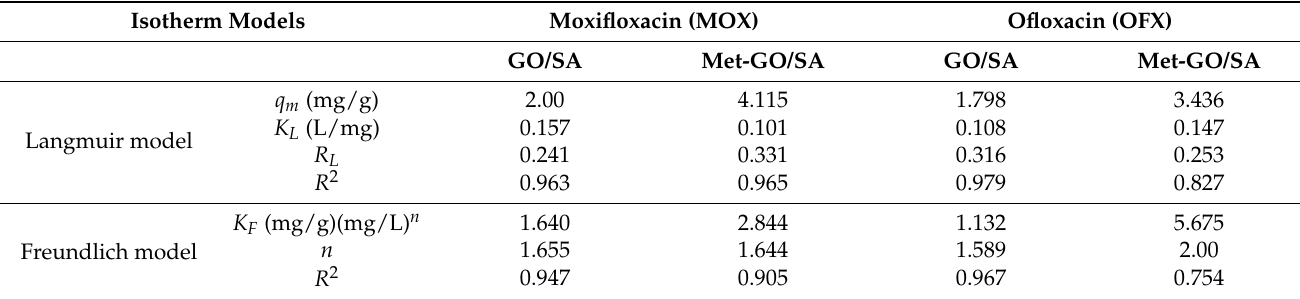
Table 3. Langmuir and Freundlich isotherm parameters for MOX and OFX adsorption on functionalized (Met-GO/SA) and non-functionalized (GO/SA) adsorbents at 35 ◦